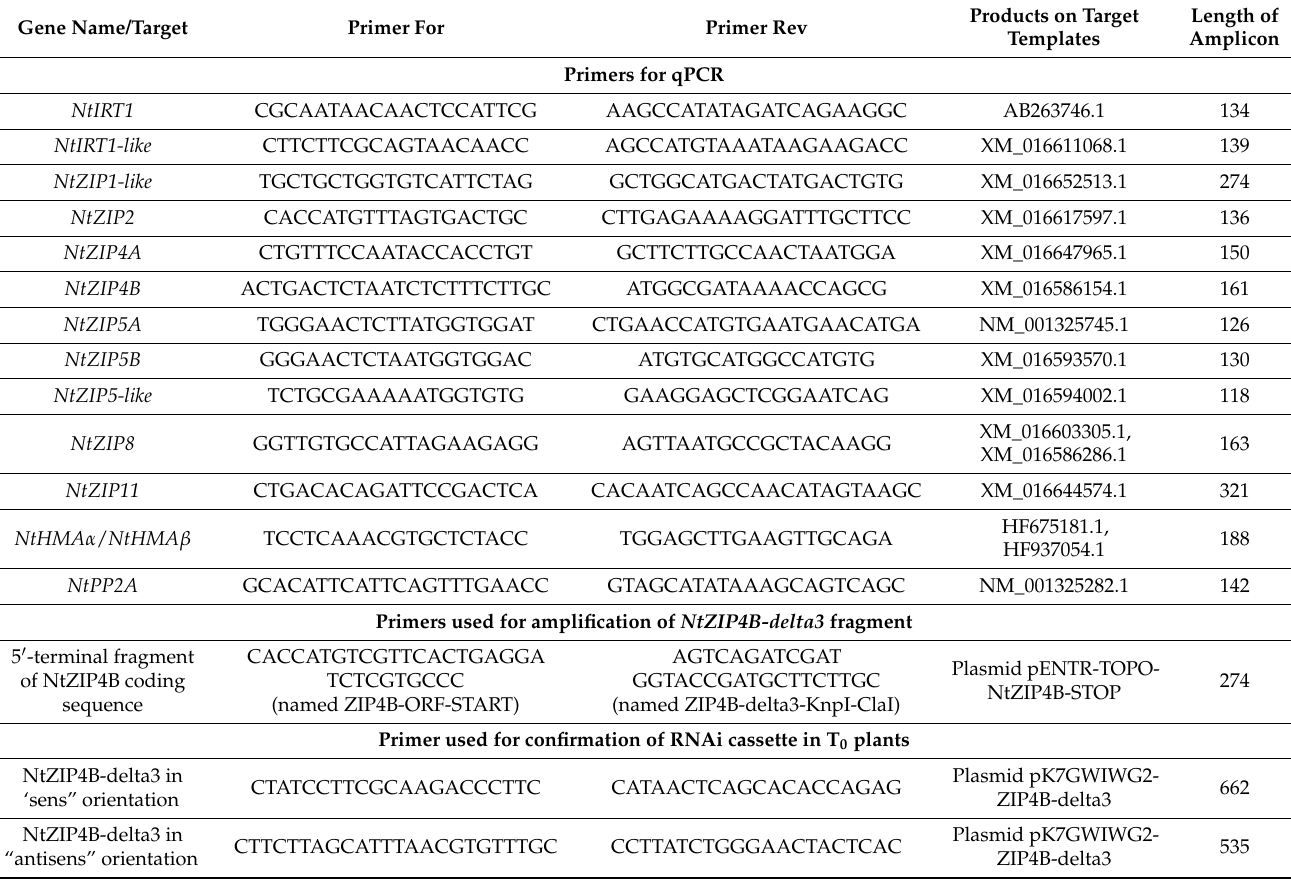
Table 1. Primers sequences used in the